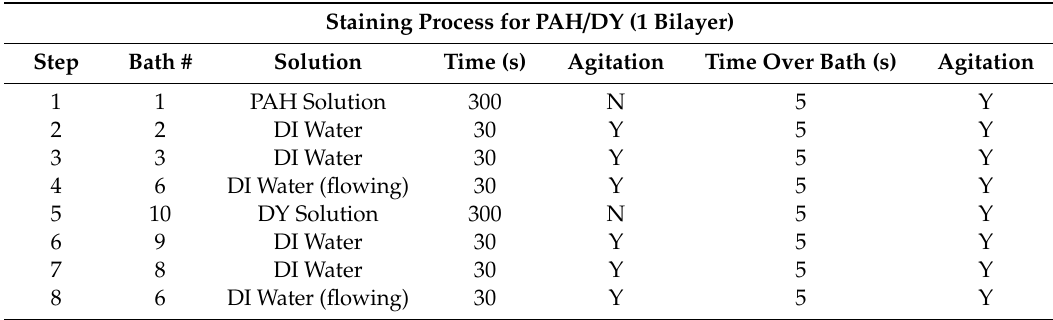
Table 1. Step sequence of one bilayer (PAH / DY) film